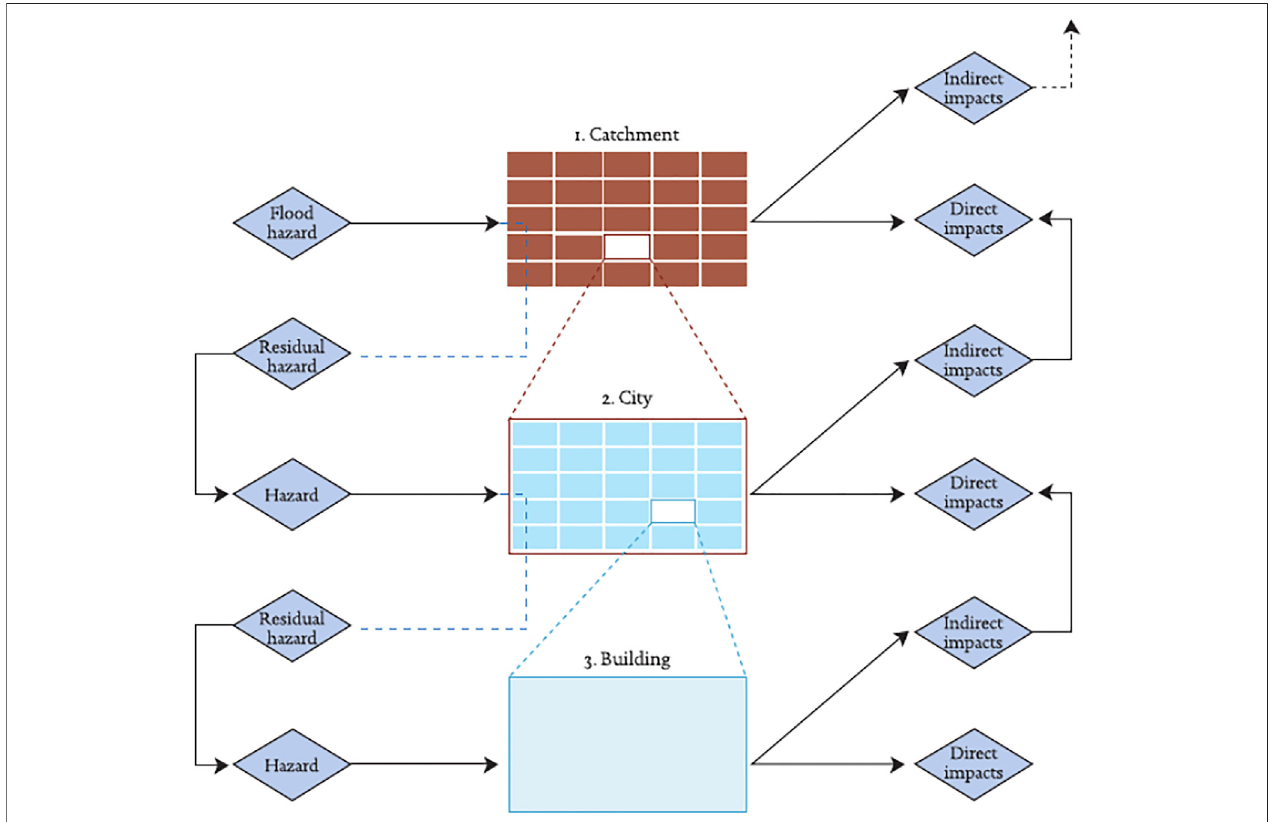
FIGURE10| Floodresilience: travellingacrossspatiallevels. Thispicturedepictsthepropagationofa fl oodwavethroughthecatchmentsystemincaseofafailure or overtopping of the primary fl ood protection system. (Zevenbergen et al., 2008).